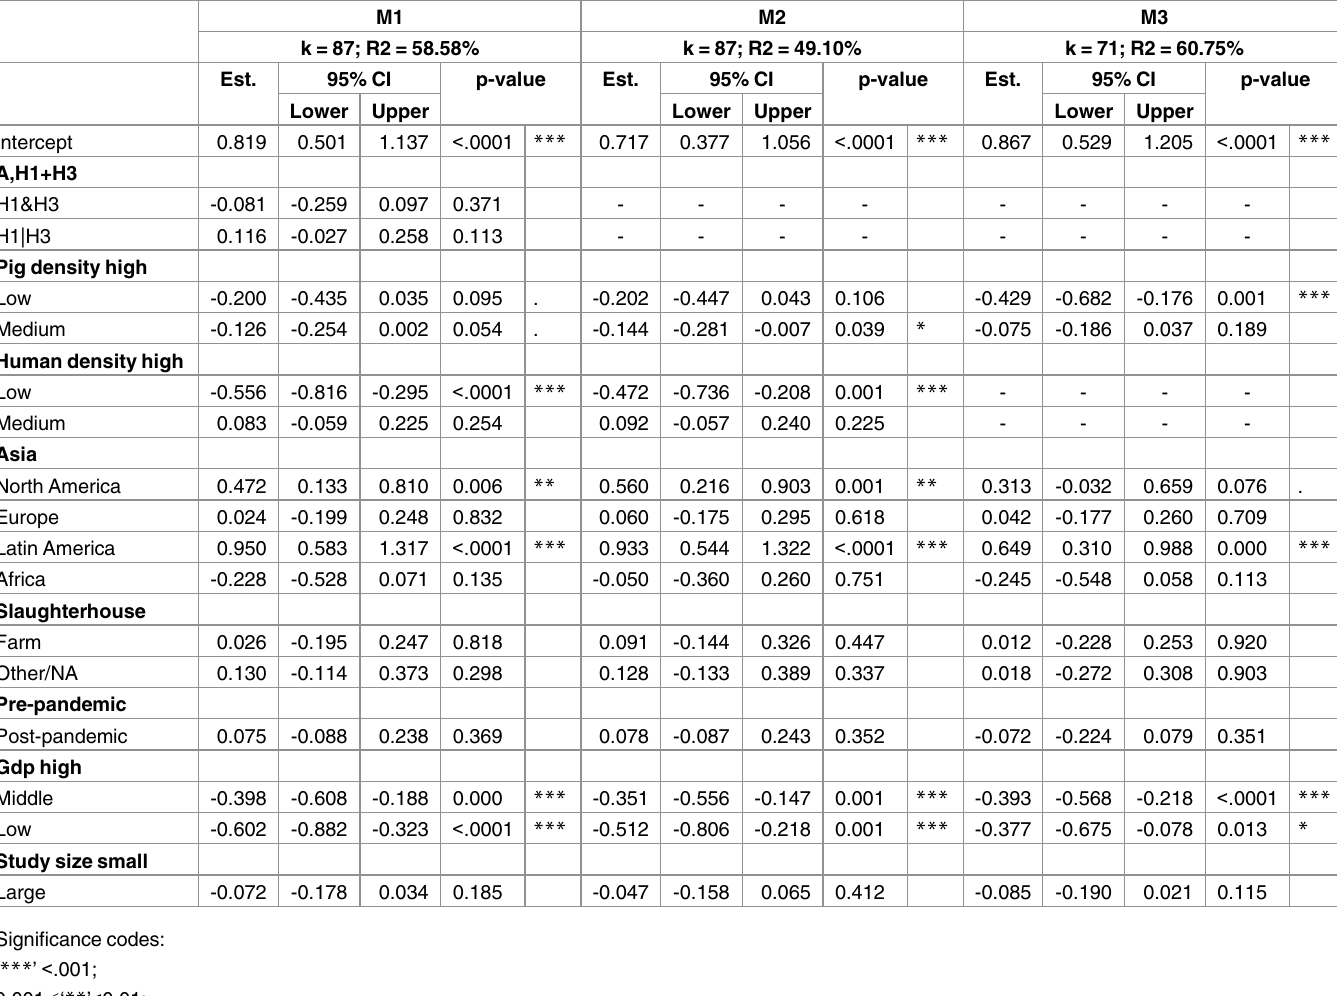
Table 4. Final mixed-effects models for herd seroprevalence for M1, M2 and M3. M1